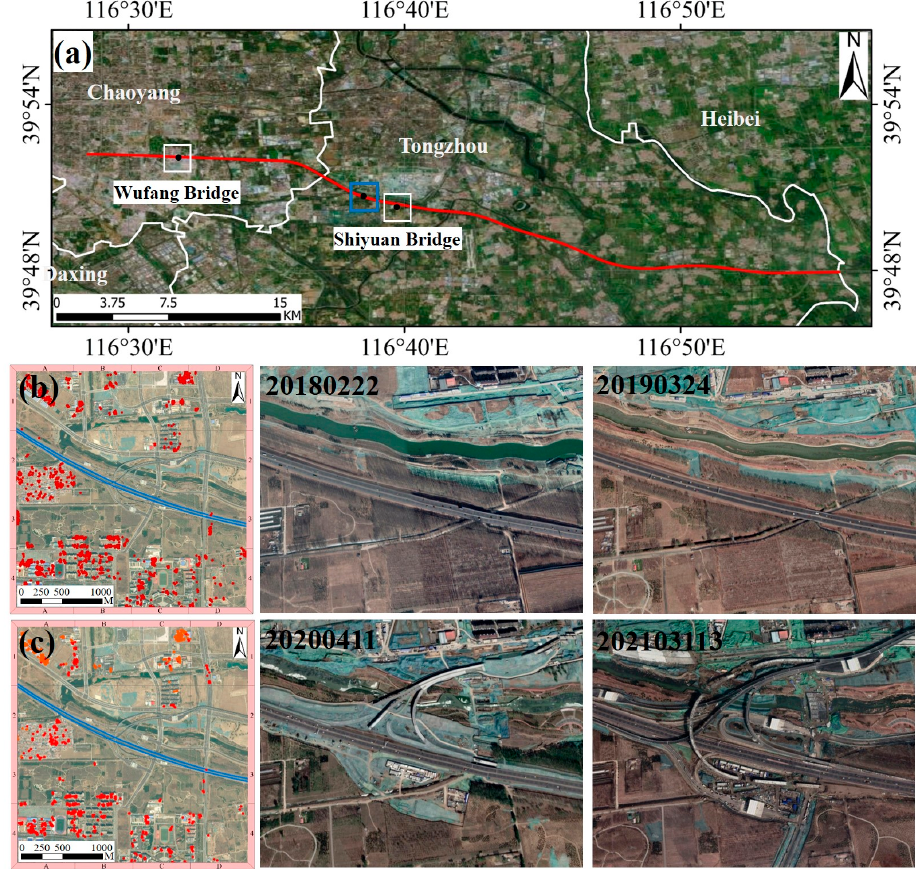
Figure 16. ( a ). Beijing section of the Beijing–Harbin Expressway. The red curve is the G1 motorway, the two white boxes indicate two important transport hubs and the blue box represents the newly constructed bridges. ( b ). Subsidence rate in the construction area from January 2018 to March 2020. ( c ). Subsidence in the construction area from February 2020 to April 2022; the blue line is G1. Other images are the conditions of this area at different times.